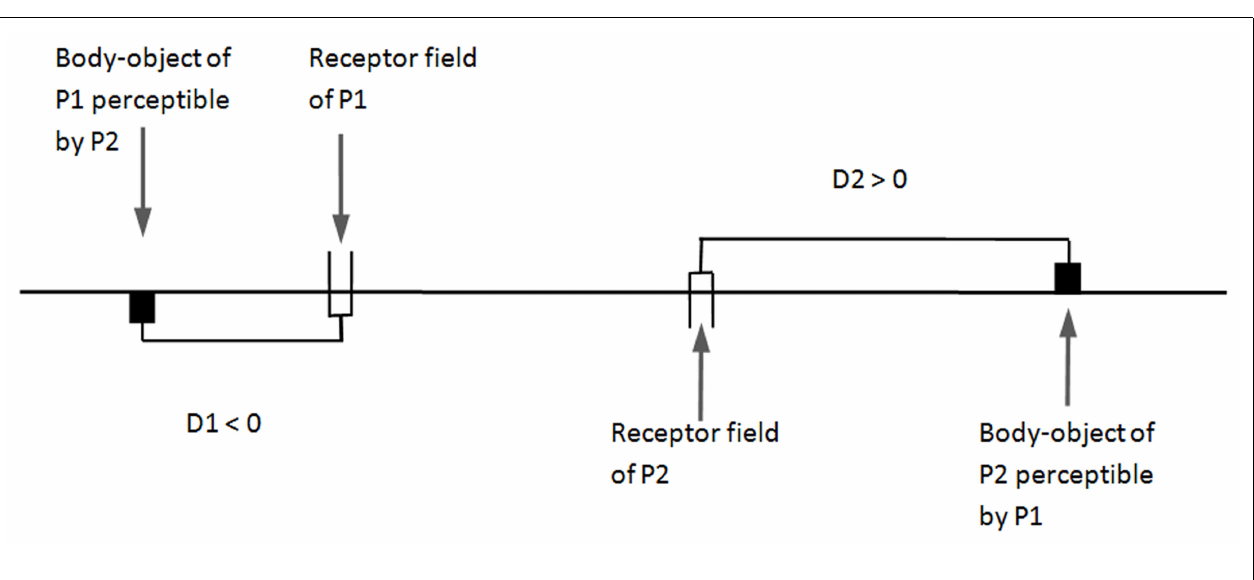
space.Their body-object follows exactly their movements.The subject receives a tactile stimulation when his receptor field covers the body-object of the partner.